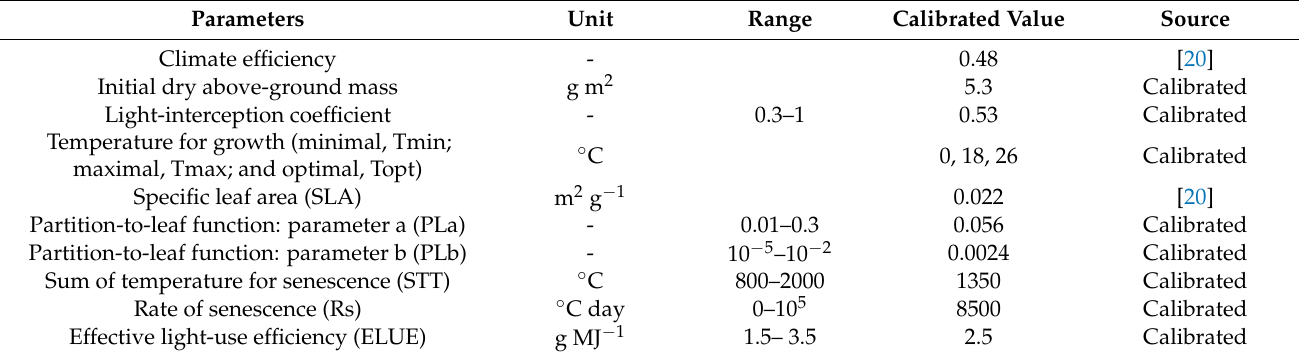
Figure 5. SAFY-modeled GLAI (blue line) and field-measured LAI (brown dot) after model calibra- tion. Table 1. SAFY model parameters used in this study.